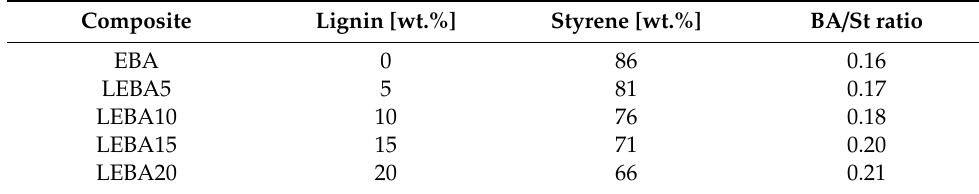
Table 1. Lignin and styrene quantity present in composites, with butyl acrylate (BA) constant in 14 wt.%. Composite Lignin [wt.%] Styrene